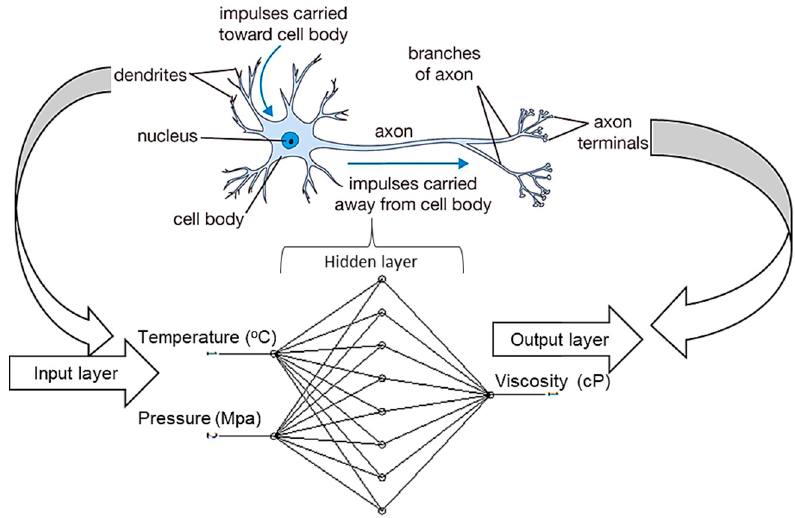
Figure 1. A typical schematic of computational neuron adopted from a biological neuron (source: adapted from Farobie et al. [18]).